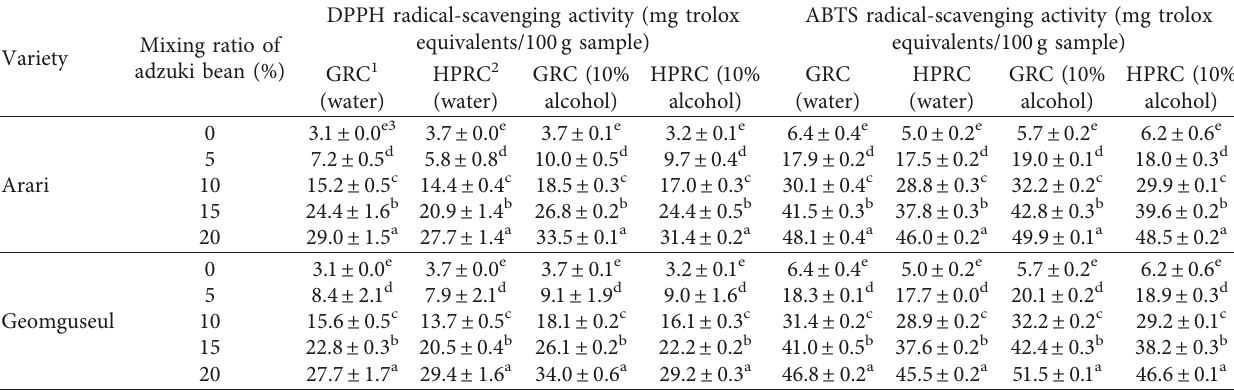
Table 6: DPPH- and ABTS-radical-scavenging activities of the ethanolic extracts with different mixing ratios of adzuki bean ( Vigna angularis var. nipponensis cv. Arari and cv. Geomguseul) and cooking methods. Mixing ratio of Variety